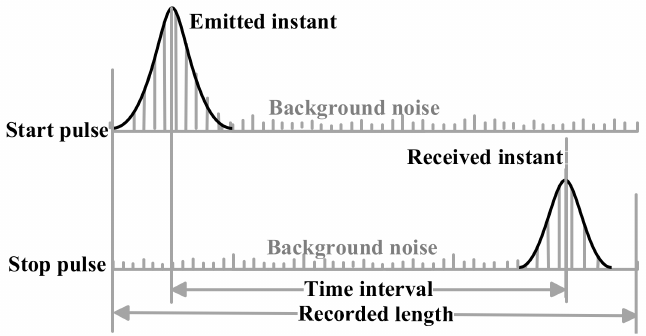
Figure 3. Time determination based on